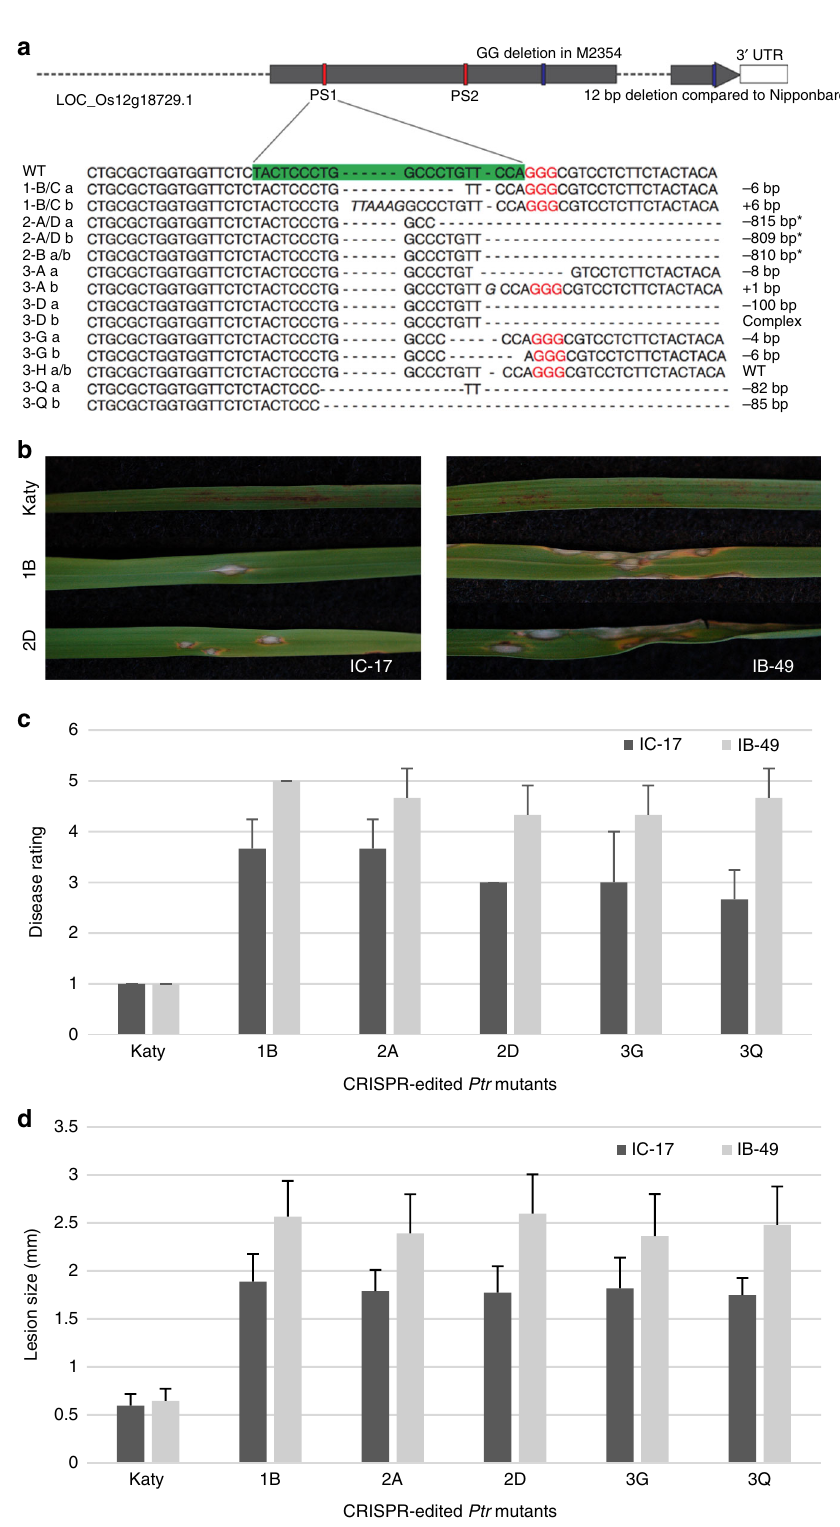
Fig. 2 CRISPR/Cas9-mediated mutation of Ptr in a resistant cultivar. a The Ptr gene was targeted with two speci fi c gRNAs to achieve knockouts. CRISPR/ Cas9 editing resulted in InDels of differing length or a fragment deletion between the two protospacer (PS) sites are indicated by asterisk (*). b Disease symptoms on wild-type Katy and CRISPR-edited Ptr mutant leaves after spray-inoculation with AVR-Pita -containing strains IB-49 (ML1) or IC-17 (ZN57). c Disease rating of Katy and Ptr mutant plants at 6 days post-inoculation with 0 – 5 rating scale where 0 – 2 is resistant and 3 to 5 is susceptible. d Average lesion length on Katy and Ptr mutant leaves at 6 days post-inoculation. Error bars indicate standard deviation (s.d.) of average lesion area and disease rating. Data represent means ± s.d. ( n =